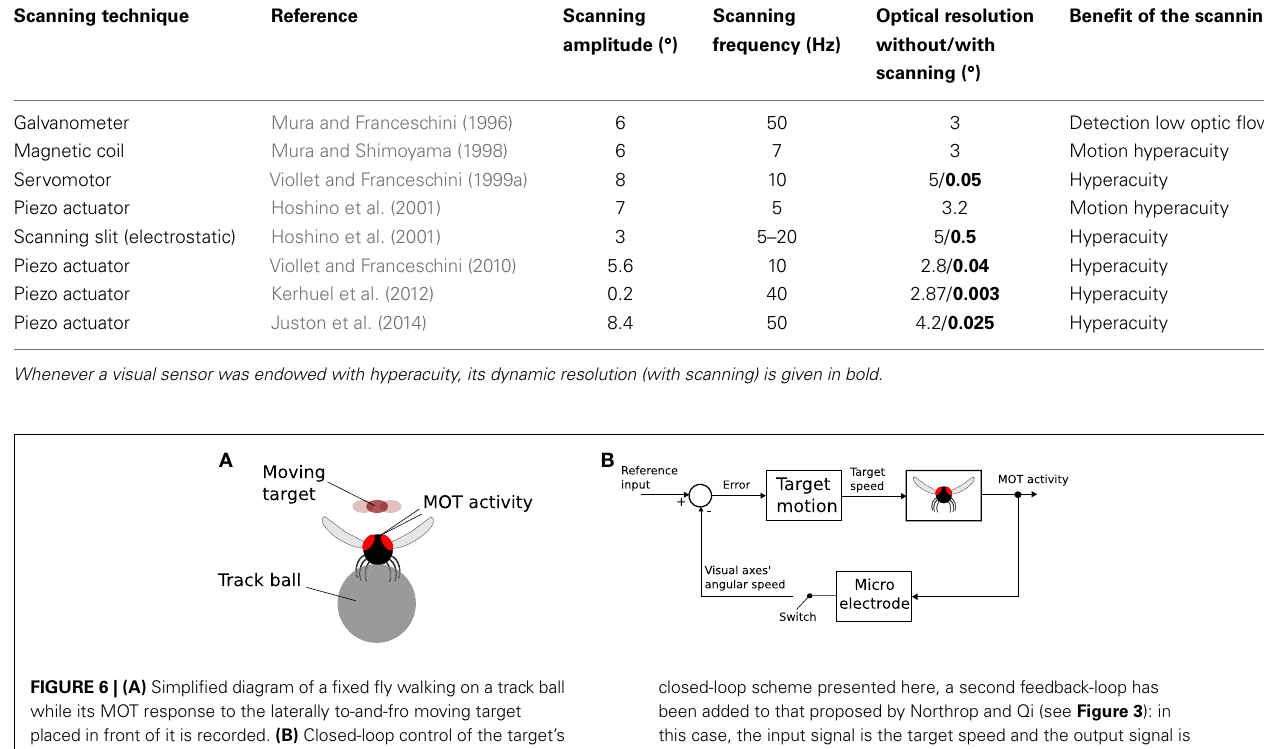
FIGURE 6 | (A) Simplified diagram of a fixed fly walking on a track ball while its MOT response to the laterally to-and-fro moving target placed in front of it is recorded. (B) Closed-loop control of the target’s speed depending on the MOT activity. If the MOT control system is correlated with the speed of the target, then the latter will remain stationary regardless of the speed reference input signal. In the